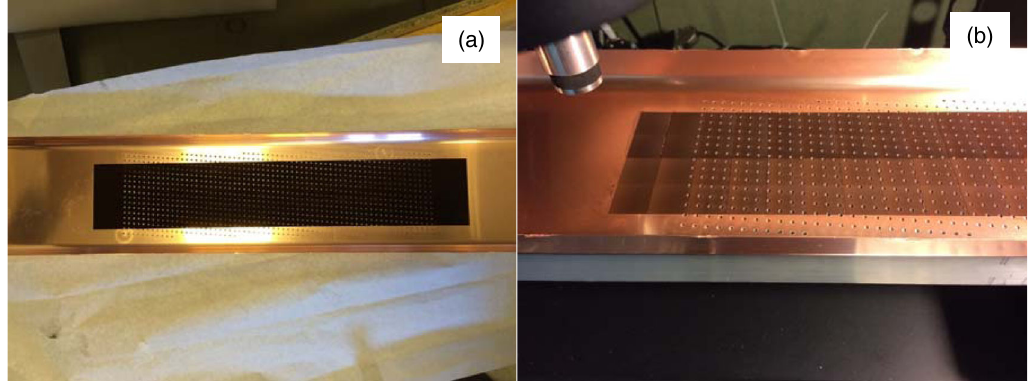
FIG. 6. Perforated side of the liners treated (a) at the University of Dundee, and (b) by ASTeC. In (b), the two regions treated with a different set of laser parameters are clearly visible, the darker area having been treated at 90 mm = s.